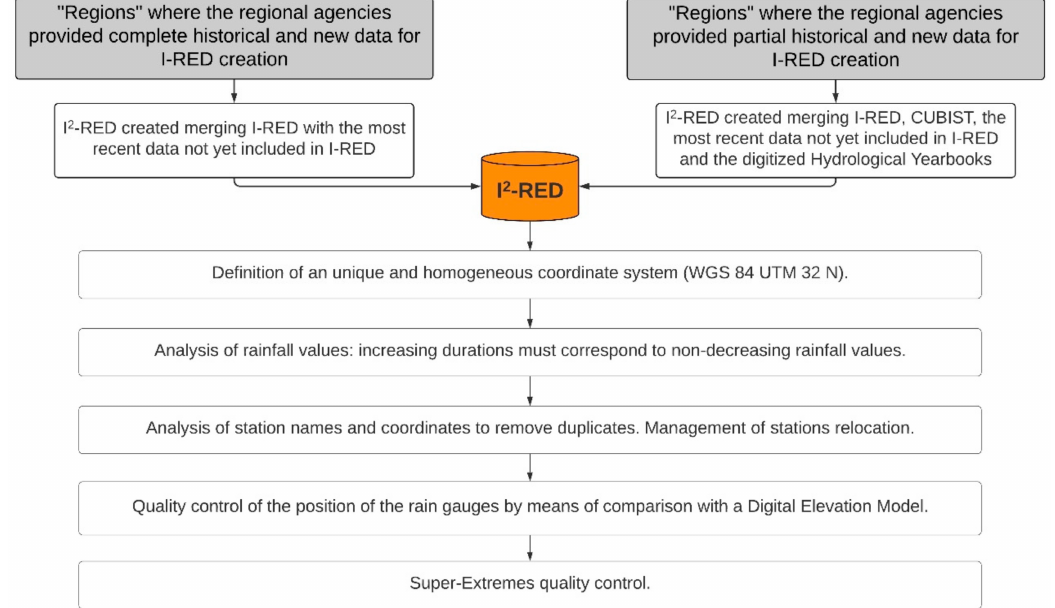
Figure 2. Quality control workflow applied during the creation of I 2